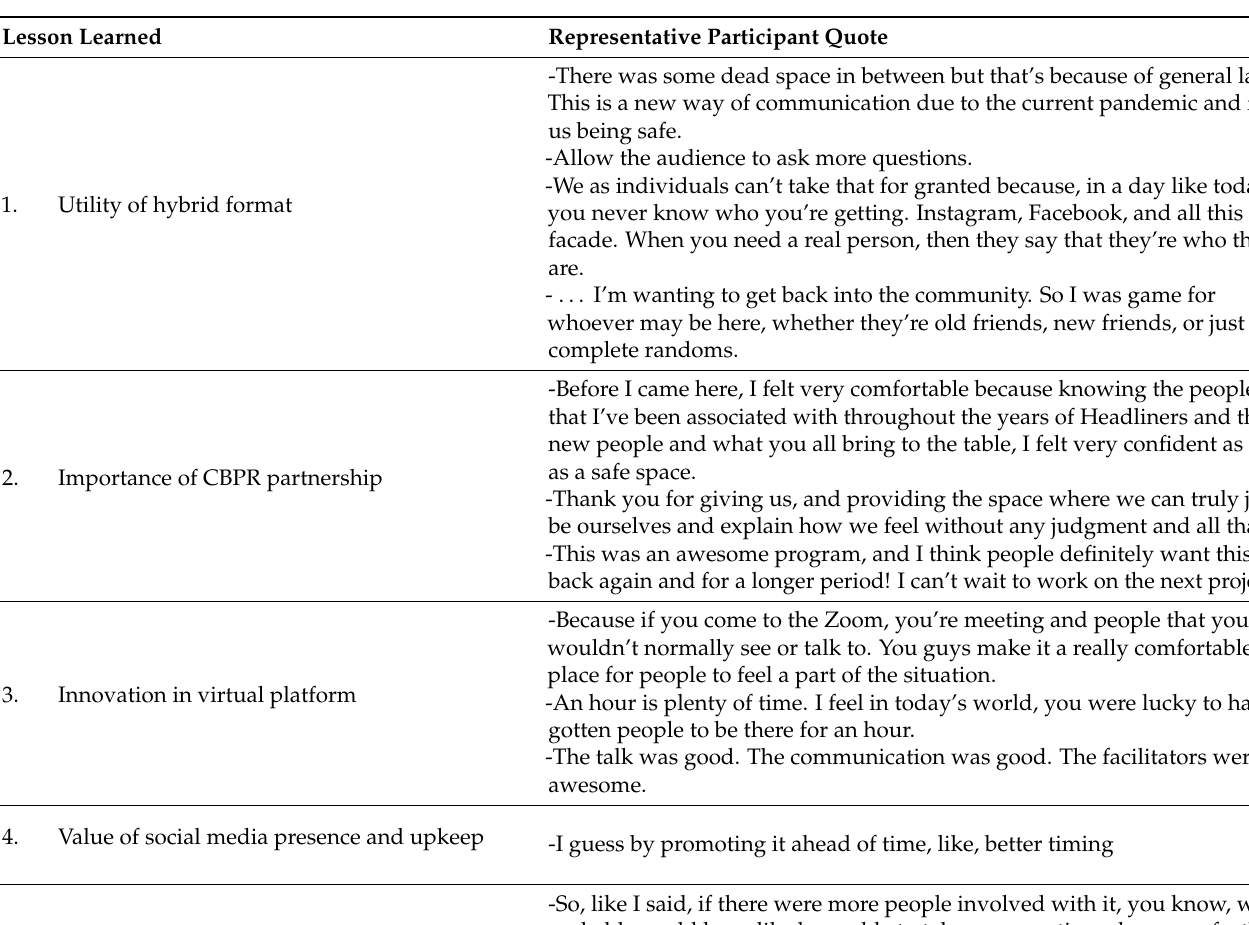
Table A3. Post-session feedback from Whole YOUniversity